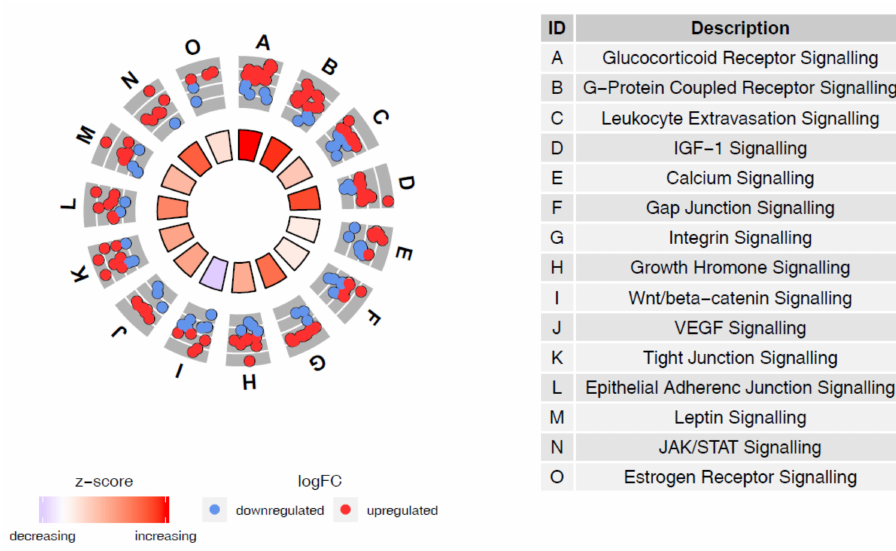
Figure 5. Circular plot of IPA canonical pathways enriched with miRNA targets differentially expressed between MS and ES endometrial samples of fertile women. The inner circle represents the overall up- or down-regulation of gene expression in each pathway according to the z-score. The outer circle depicts the fold change of expression level for each